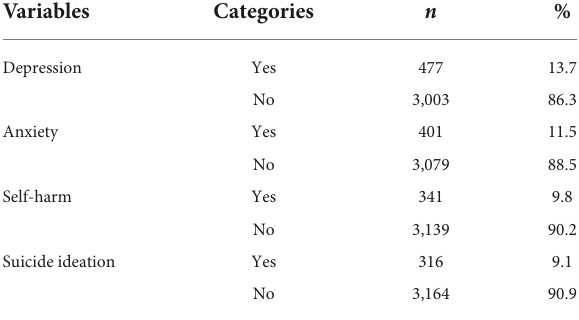
TABLE 2 Mental health problems ( n =